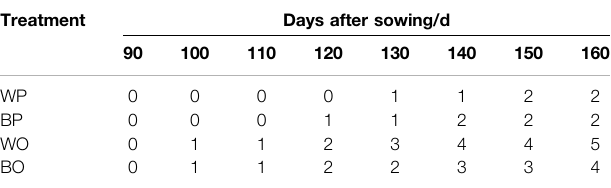
TABLE 1 | Degradable rates of different mulching fi lms. Treatment